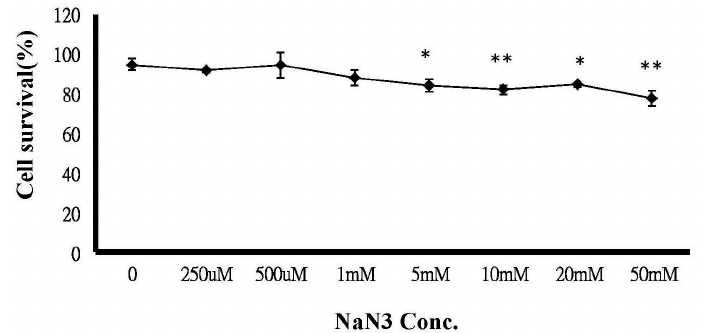
Figure 4. Chemosensitivity of MCF-7/MX cells to MX is significantly affected by NaN3. MCF-7/MX cells were seeded onto 96-well plates. Following 24 h incubation, cells were treated with 4 h ATP depletion with varying concentrations, including 0, 250 and 500 µM 1, 5, 10, 20 and 50 mM sodium azide. Cells were then treated in triplicate with 300 µM. MX cell viability was determined by MTT assay ( n = 3). The values represent the mean ± standard deviation obtained from triplicate experiments. * p < 0.05, ** p < 0.005.